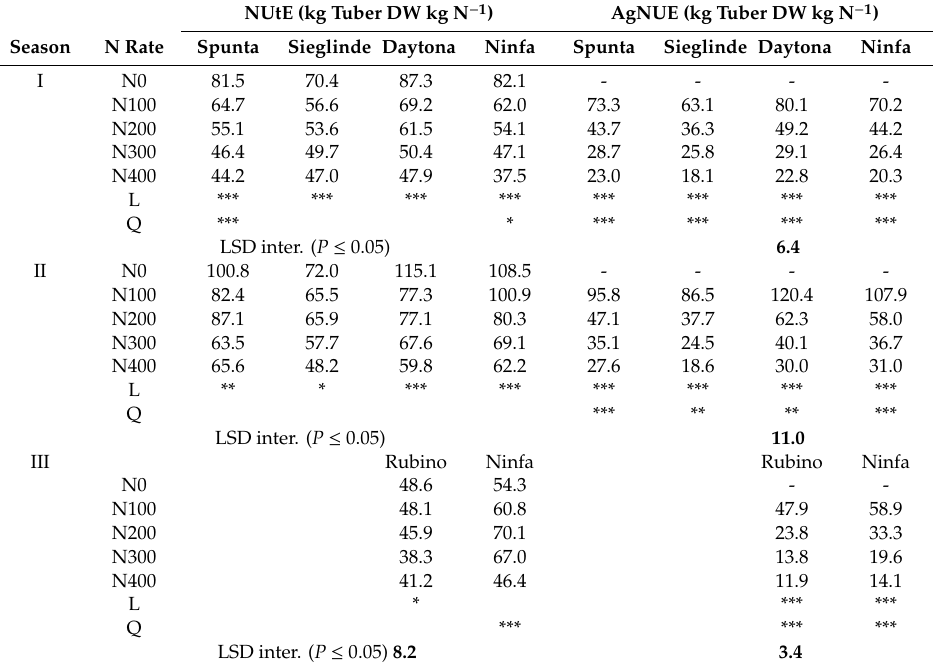
Table 6. NUtE (nitrogen utilization e ffi ciency) and AgNUE (agronomical nitrogen use e ffi ciency) as a ff ected by the “nitrogen rate x cultivar” interaction in the three seasons. Relationship tested by regression analysis, between N rate and responses of each variable and cultivar (L = linear, Q = quadratic; *, **, *** indicate significance at P < 0.05; P < 0.01; P <